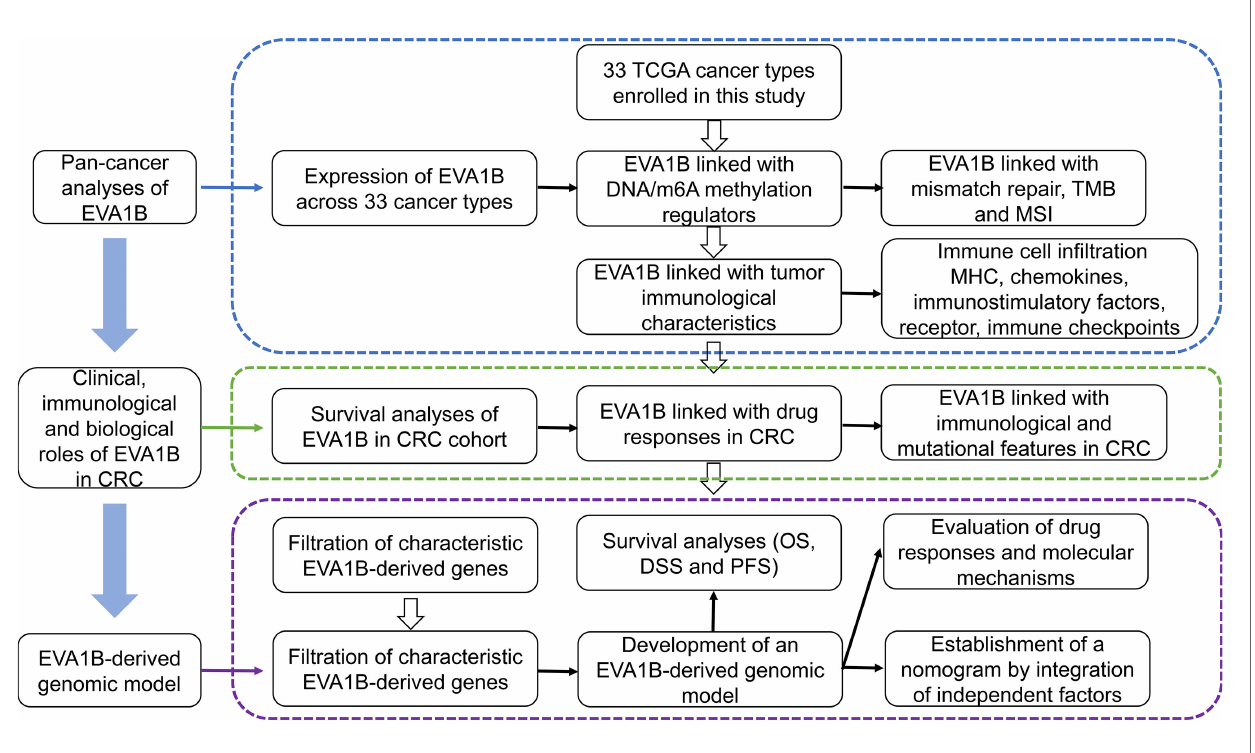
FIGURE 1 | The work fl ow of this